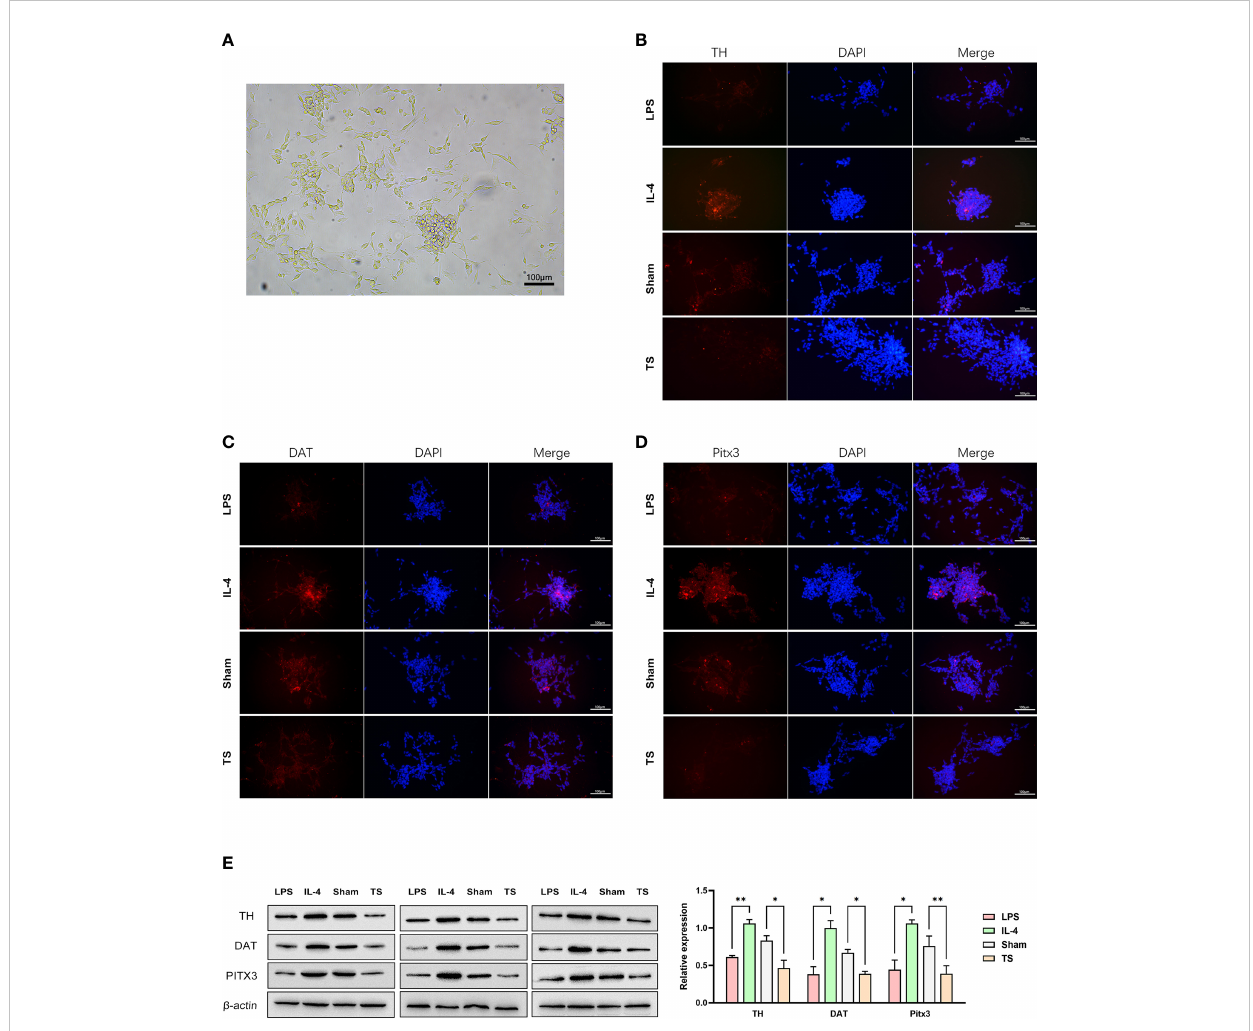
FIGURE 4 Striatal dopaminergic neurons were co-cultured with microglia of different polarization statuses. (A) Striatal dopaminergic neurons are cultured. (B) Immuno fl uorescence staining of TH expression in different groups: co-cultured with LPS-treated microglia, IL-4 treated microglia, control- animal-derived striatal microglia, and TS-rat-derived microglia. (C) Immuno fl uorescence staining of DAT expression in different groups. (D) Immuno fl uorescence staining of PITX3 expression in different groups. (E) Western blot analysis of the expression of TH, DAT, and PITX3 in different co-culture groups. *P <0.05, **P